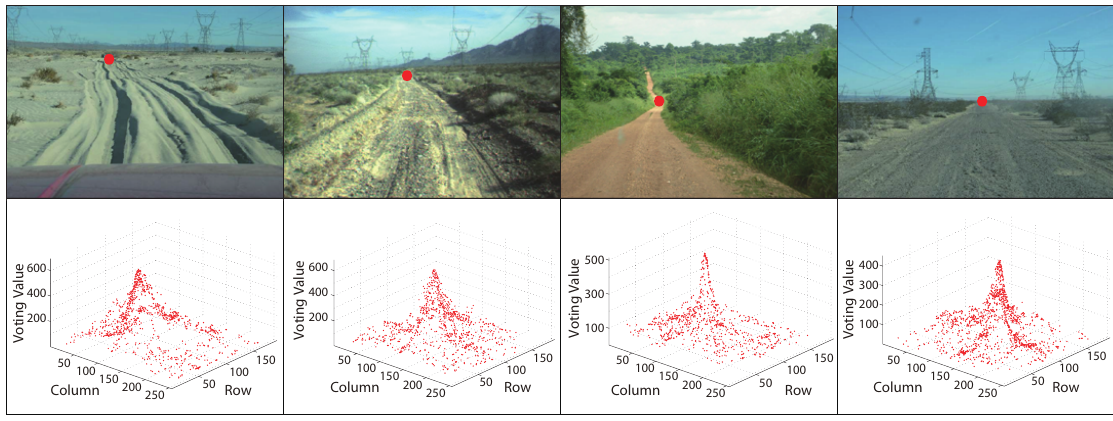
Figure 5. Examples of MPGA-based vanishing point detection in unstructured